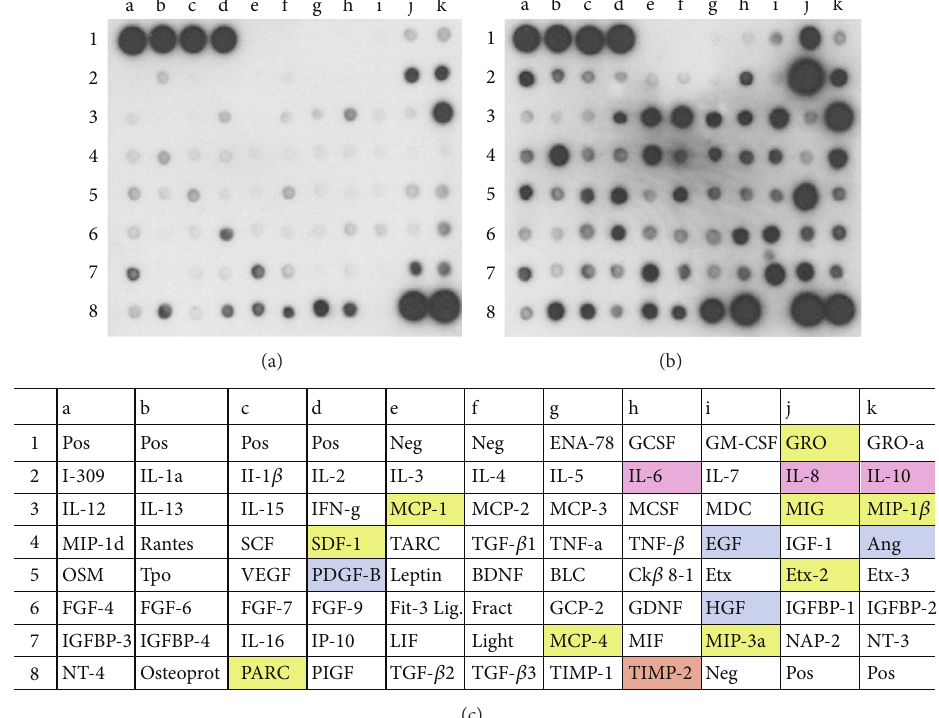
Figure 3: Protein antibody array detecting cytokines in human umbilical cord blood (hUCB)-cell conditioned media (see [22, Figure 7]). Representative examples of two antibody array membranes, incubated with either nonconditioned culture medium (a) or culture medium conditioned by hUCB-derived mononuclear cells for 2 days (b). Increasing intensity reveals increased secretion of the cytokines investigated. Dots a1 to d1 and j8 to k8 were positive controls (Pos); dots e1 to f1 and i8 were negative controls (Neg). (c) Overview of all proteins assayed on the membrane. Boxed factors are color-coded and refer to those proteins secreted at significant levels. Colors designate interleukin proteins (purple), growth factors (blue), chemokines (yellow), as well as tissue inhibitors of metalloproteinase2 (TIMP-2) (orange). Ang: angiogenin; BDNF: brain-derived neurotrophic factor; BLC: B-lymphocyte chemoattractant; EGF: epidermal growth factor; ENA-78: epithelial neutrophil-activating protein-78; Etx; eotaxin; FGF; fibroblast growth factor; Fract: fractalkine; GCP-2: